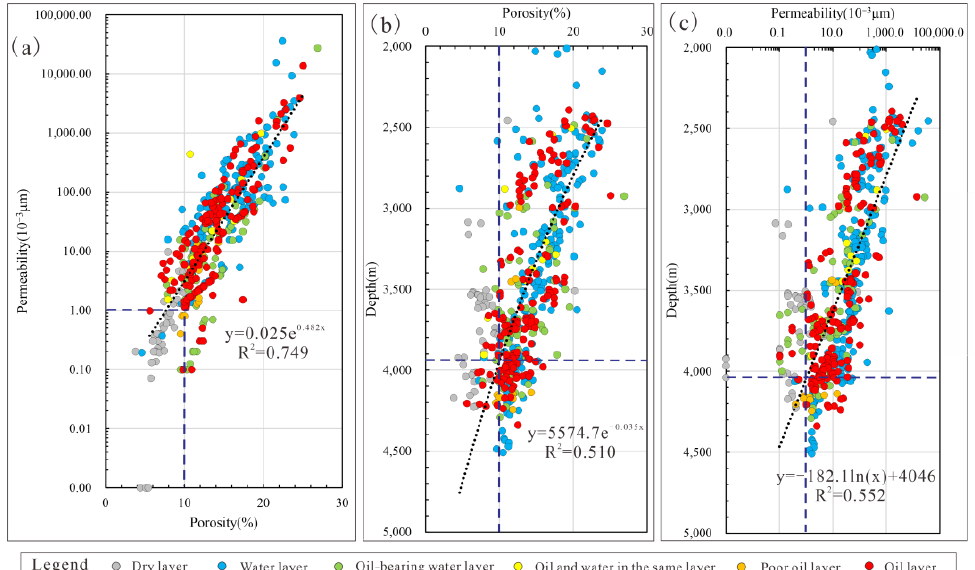
Figure 19. ( a ) Relationship between reservoir porosity and permeability in the Lufeng sag; ( b ) reservoir porosity varies with depth in the Lufeng sag; ( c ) reservoir permeability changes with depth in the Lufeng sag.